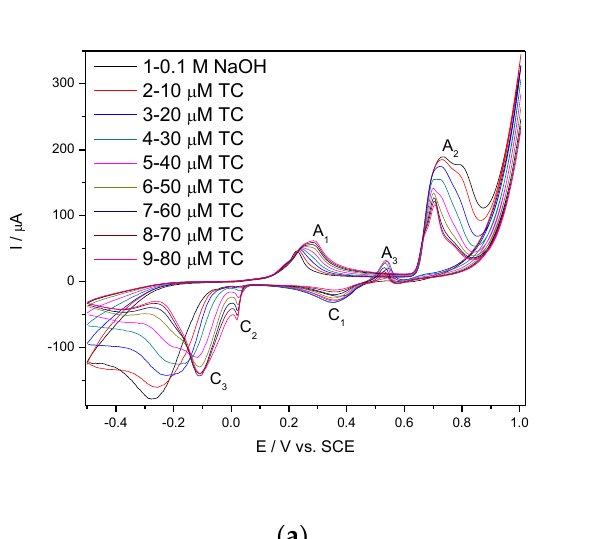
Nanomaterials 2021 , 11 , x FOR PEER REVIEW Figure 5. ( a ) CVs recorded at the scan rate of 0.05 V·s − 1 in 0.1M NaOH supporting electrolyte and TC concentrations ranged Figure 5. ( a ) CVs recorded at the scan rate of 0.05 V · s − 1 in 0.1M NaOH supporting electrolyte and TC concentrations ranged from 10 to 80 µM on the electrode Ag/GO/BDD. ( b ) Calibrations plots of peak current vs TC concentrations at the potential from 10 to 80 µ M on the electrode Ag/GO/BDD. ( b ) Calibrations plots of peak current vs. TC concentrations at the potential value: E A1 = +0.287 V/SCE (anodic), E C2 = +0.020 V/SCE (cathodic). value: E A1 = +0.287 V/SCE (anodic), E C2 = +0.020 V/SCE (cathodic).